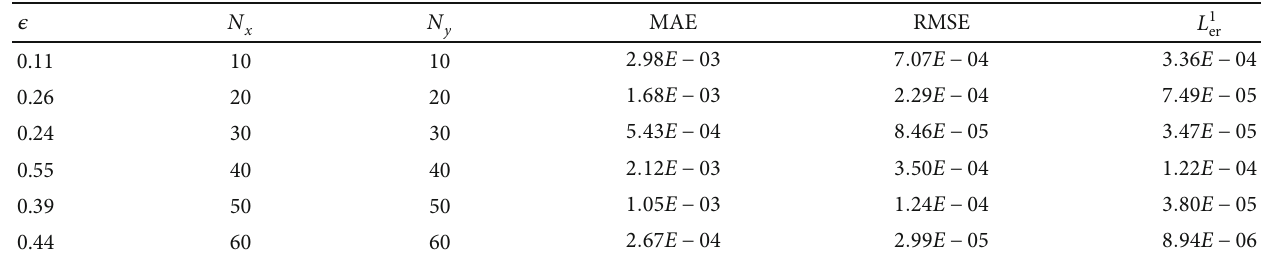
, N , and ϵ using x y